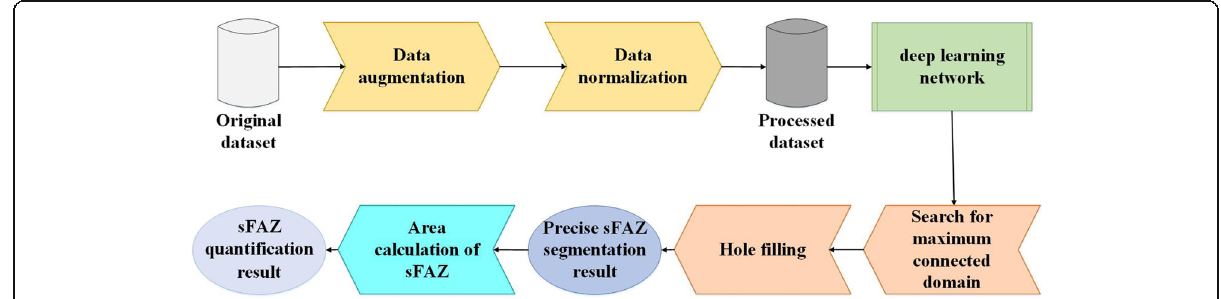
higher values resulted in darker images with fewer visible capillaries. At different scales, the capillaries and noise had different degrees of visualization. In total, 405 OCTA im- ages of the superficial retina were exported for image analysis. The ground truth (GT) of the sFAZ was generated